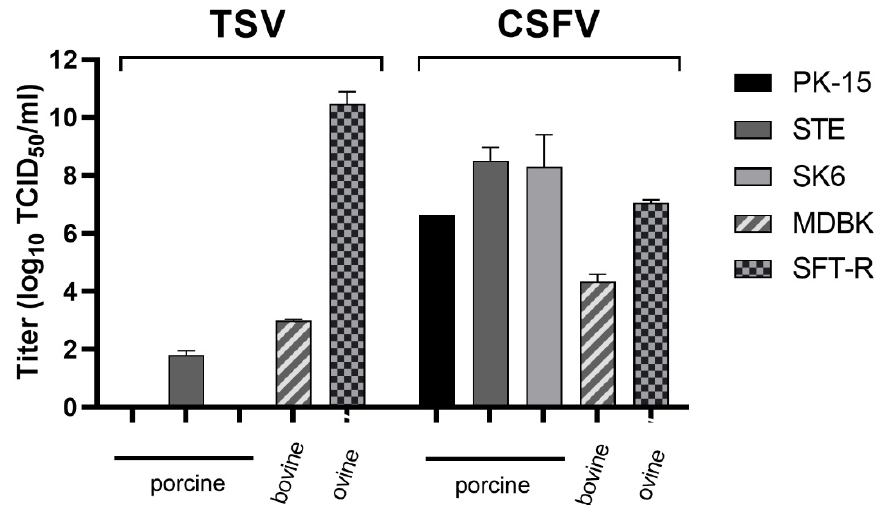
Figure 2. Viral replication of Tunisian sheep-like virus (TSV isolate 70282/2007/EN) and classical swine fever virus (CSFV strain Diepholz) on different cell lines using a multiplicity of infection (MOI) of 0.1. The virus titers were determined as 50% tissue culture infectious doses (TCID 50 ) per mL at 72 hours post infection. The porcine kidney cell lines PK-15 and SK6 as well as the swine testis cell line STE were used. Additionally, the bovine MDBK and the ovine SFT-R cell line were included to characterize the permissivity.